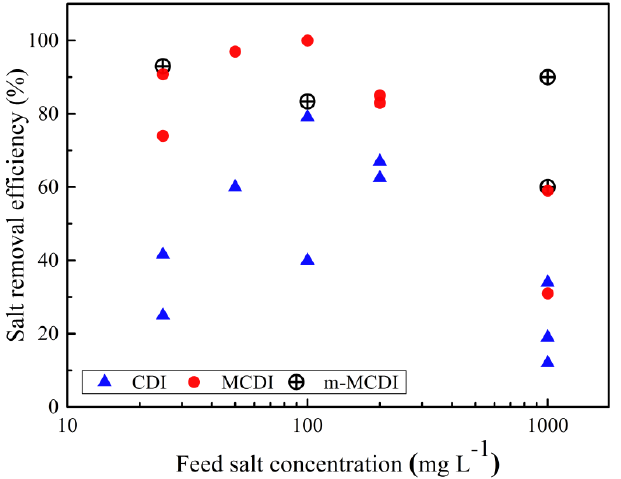
Figure 4. Salt removal efficiencies as a function of feed salt concentration from recent research reports on Capacitive Deionisation (CDI), MCDI, and modified MCDI (m-MCDI) [14,24,26,29–31,39–42].